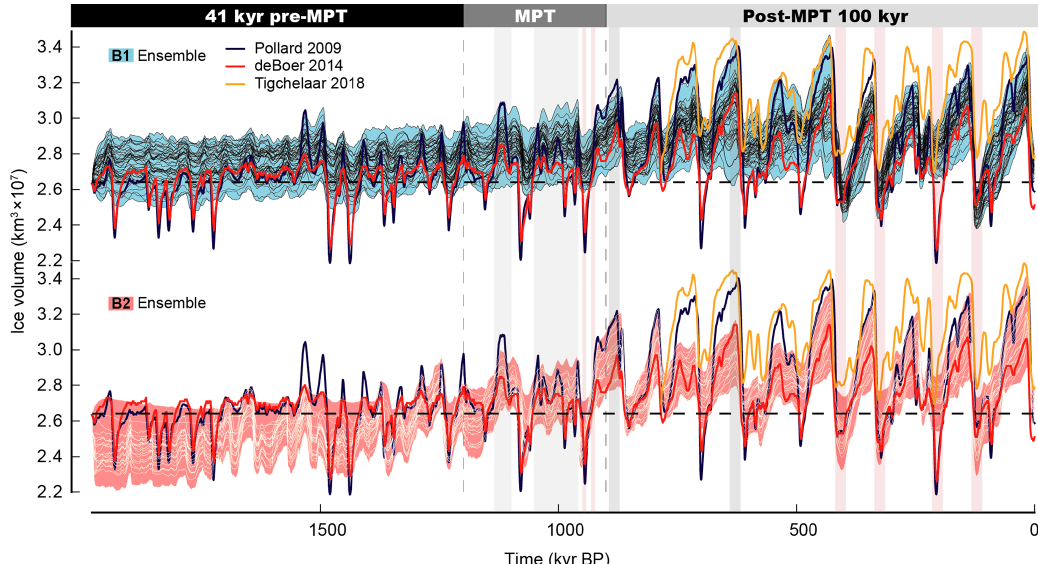
Figure 5. Antarctic ice volume as simulated in the full model ensemble (excluding simulations with either present-day ice volume larger than 2 . 8 × 10 7 km 3 or Last Glacial Maximum ice-sheet volume smaller than 3 . 0 × 10 7 km 3 ). The horizontal black dashed line denotes present-day ice volume derived from BEDMAP2 (Fretwell et al., 2013).